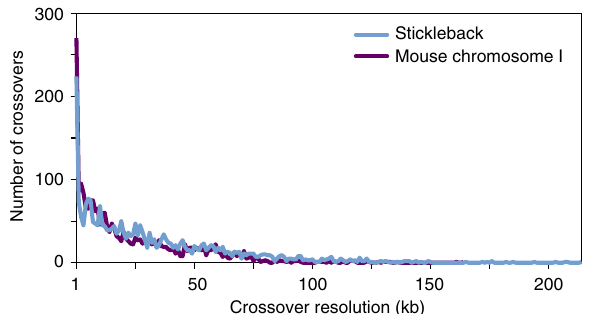
Fig. 5 ReMIX detects recombination crossovers with high resolution in both mouse (purple) and stickleback (blue). After stringent fi ltering of reads ReMIX achieved a mean of 8.3 and 8.5 reads per molecule, and a median crossover resolution of 14 and 23 kb for mouse chromosome 1 and stickleback whole genome, respectively. This is considerably higher than previous studies of mice (e.g. median resolution of 225 kb in Paigen et al. 8 ) and close to the maximally achievable resolution based on the biological constraint of distance between heterozygous sites in these strains. The highest crossover resolution we achieved was 1 bp in both mouse and sticklebacks, while only 1.22% and 4% of the crossovers detected had resolution as low as 100 kb or more for mouse and stickleback,